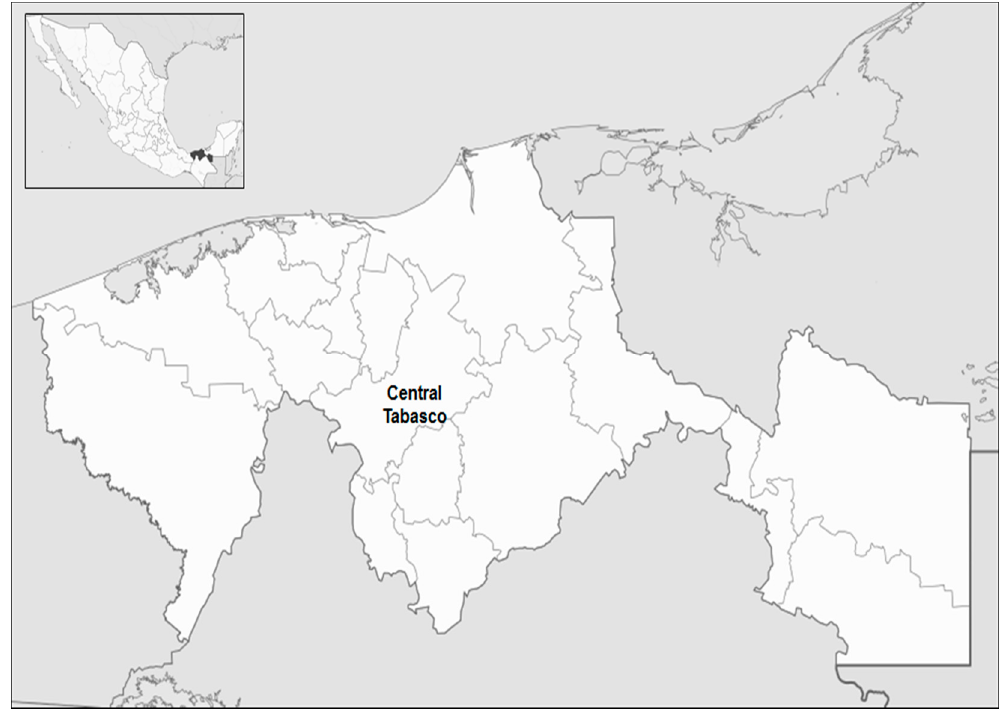
Figure 1. Tabasco state map; location of the population to be studied.